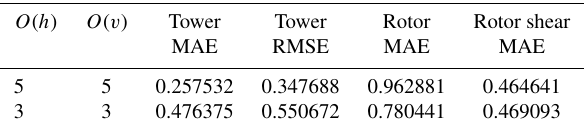
Table 3. Analysis of HiGrad performance using different advection schemes with the Lilly SFS